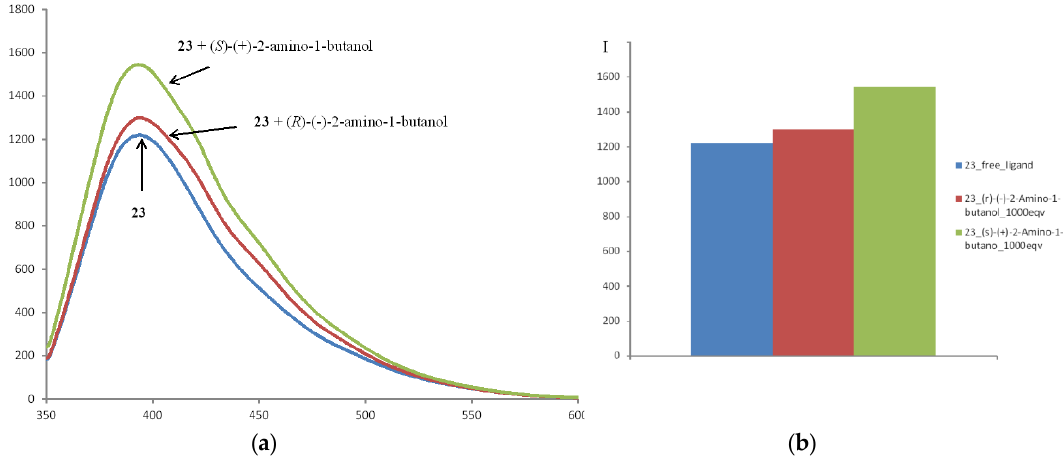
Figure 10. Fluorescence spectra of compound 23 in the presence of ( R )- and ( S )-enantiomers of 2-amino-1-butanol (1000 equiv.); ( a ) general view; ( b ) schematic representation of the changes in emission.